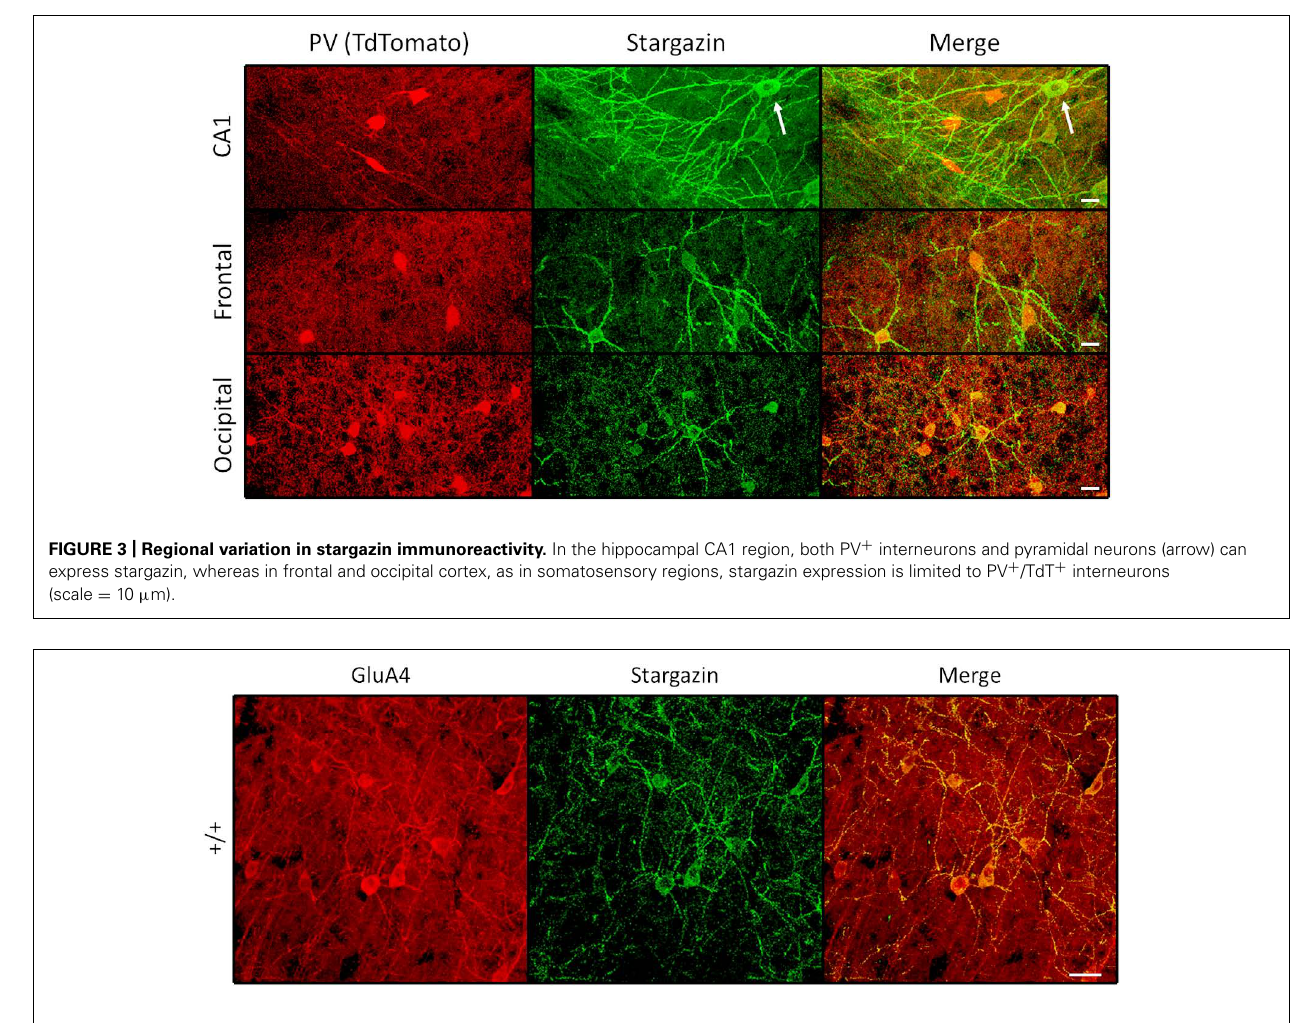
FIGURE 4 | Stargazin expression in PV + interneurons, shown here in layers 5/6 ofWT somatosensory cortex, is somatodendritic and associated with dendritic GluA4 expression (scale = 20 μ